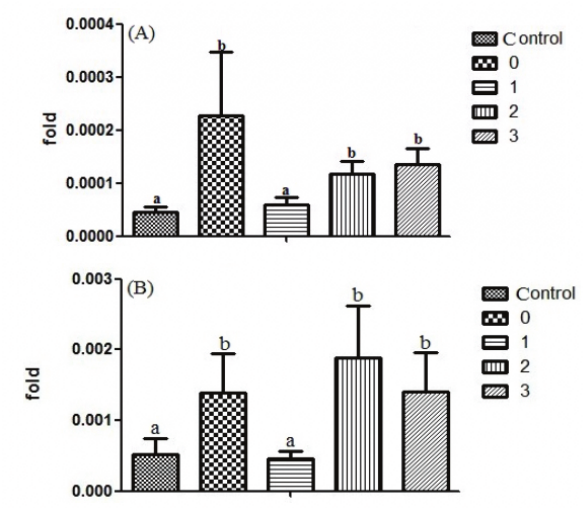
Figure 4: The gene expression of CXCR3 and CXCL10 in the lung tissue. (A) The expression of CXCR3 in lung of the mice with different treatments; (B) The expression of CXCL10 in lung of the mice with different treatments. Different letters indicated significantly diffe- rent (P<